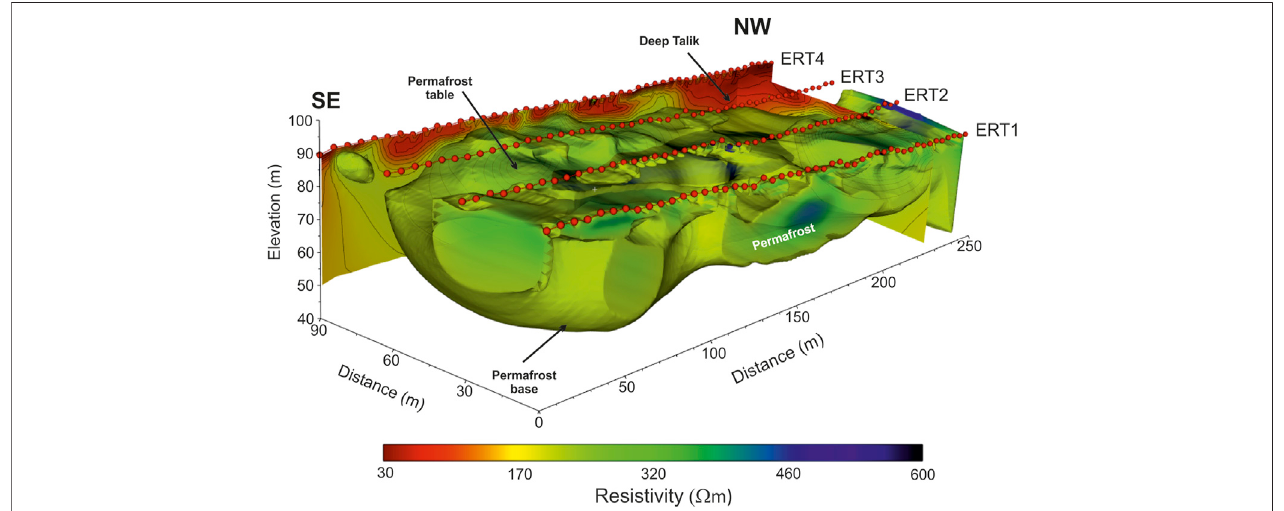
FIGURE 10 | Permafrost volume obtained by a 3D interpolation of the resistivity values higher than 200 Ω m over the four ERT sections of Site 1A. Permafrost thickness substantially reduces and becomes discontinuous upon approaching the riverbank.